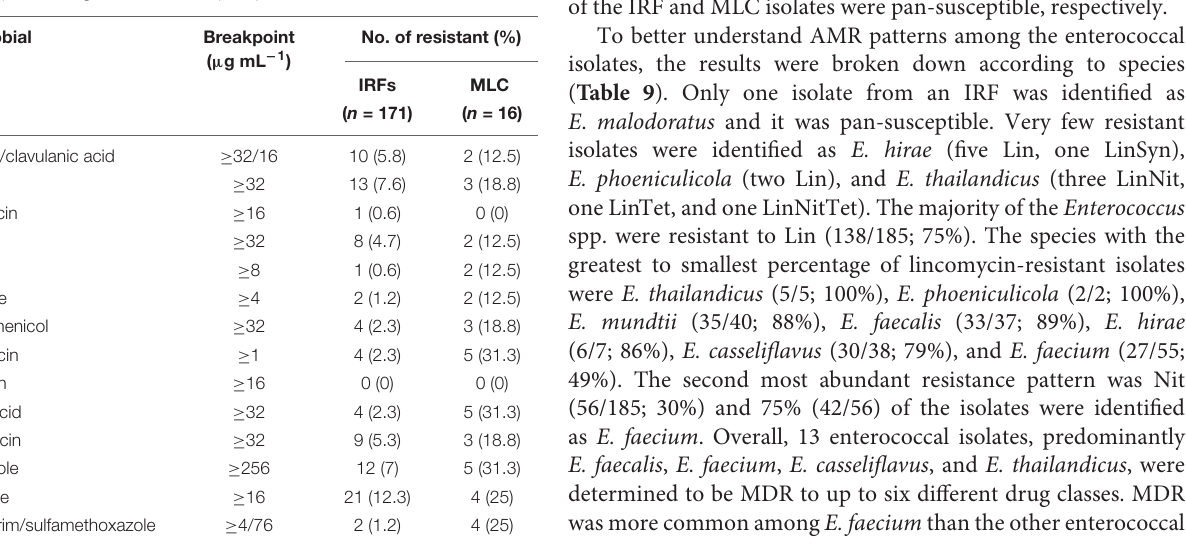
Table 6 . All seven phylogroups were represented in isolates from the IRFs, while five out of seven were represented in the MLC isolates. In IRF isolates, B1 (eight isolates) and D1/D2 (three isolates each) were the most and least abundant groups, respectively. In MLC isolates, the phylogroups represented were A1 (three isolates), B1 (one isolate), B2.3 (two isolates), D1 (one isolate), and D2 (one isolate). Among the IRF isolates, the greatest number of resistances was to five antimicrobials, and was noted in isolates belonging to groups A1 and D1, while an MLC isolate belonging to group A1 was resistant to 10 antimicrobials. Two other MLC isolates belonging to groups A1 and B2.3 were also found to be resistant to the same seven antimicrobials (i.e., ChlCipNalStrFisTetSxt).